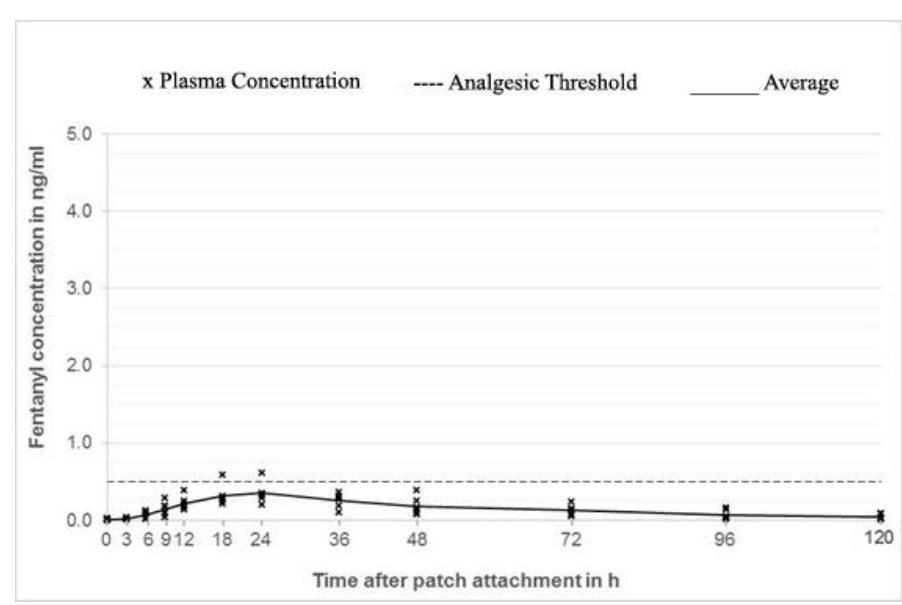
Figure 4. Fentanyl plasma concentrations group 2 (inner surface of the ear).